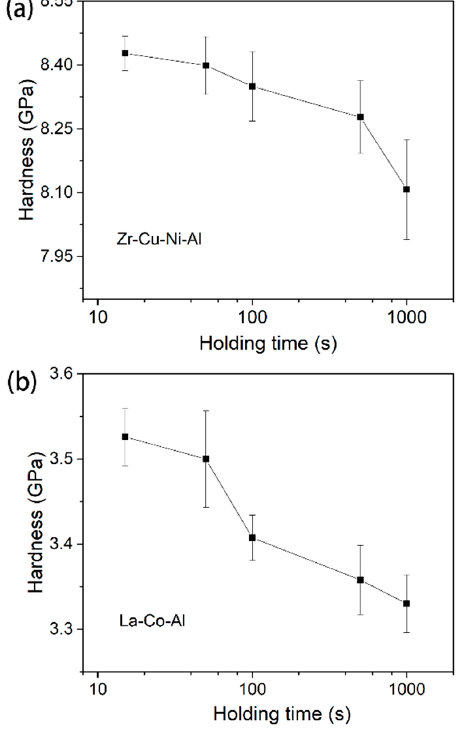
Figure 9. Hardness at the onset of the holding stage as a function of holding time for ( a ) Zr-Cu-Ni-Al and ( b ) La-Co-Al.